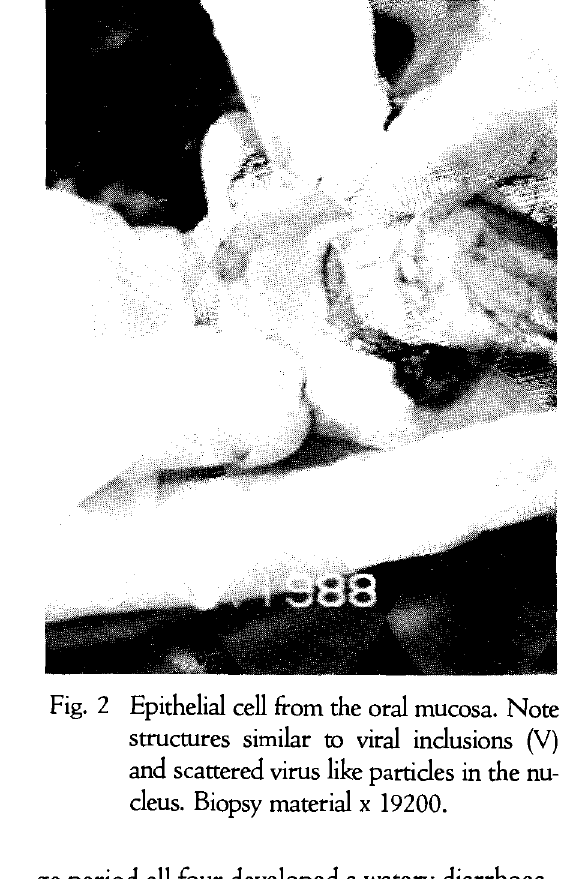
Fig. 2 Epithelial cell from the oral mucosa. Note structures similar to viral inclusions (V) and scattered virus like particles in the nu cleus. Biopsy material x